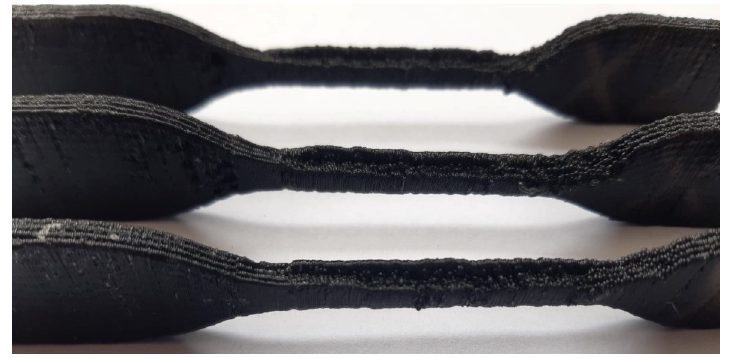
Figure 17. Laser assisted FFF printed tensile specimen.